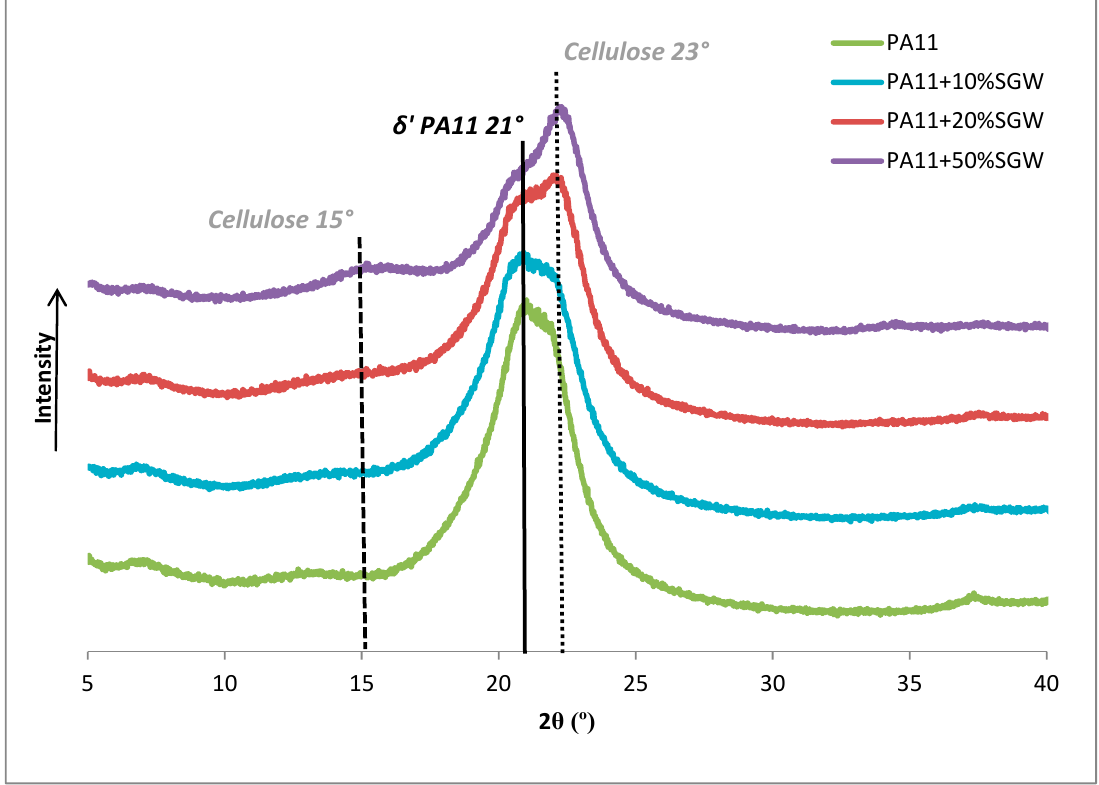
Figure 5. X-ray diffractograms of PA11 and PA11-SGW composites.